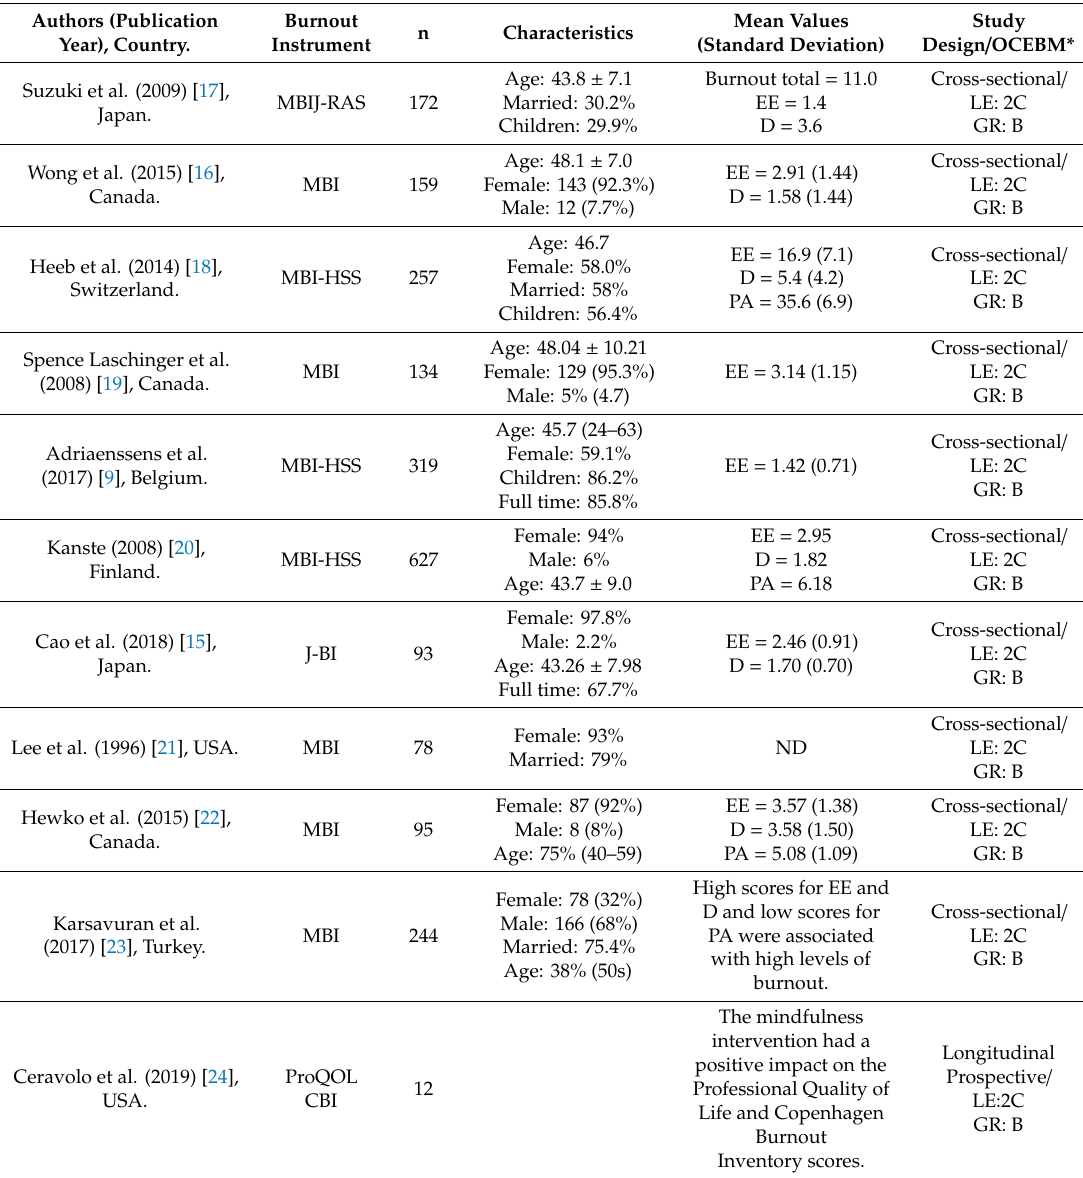
Table 1. Main results included in the